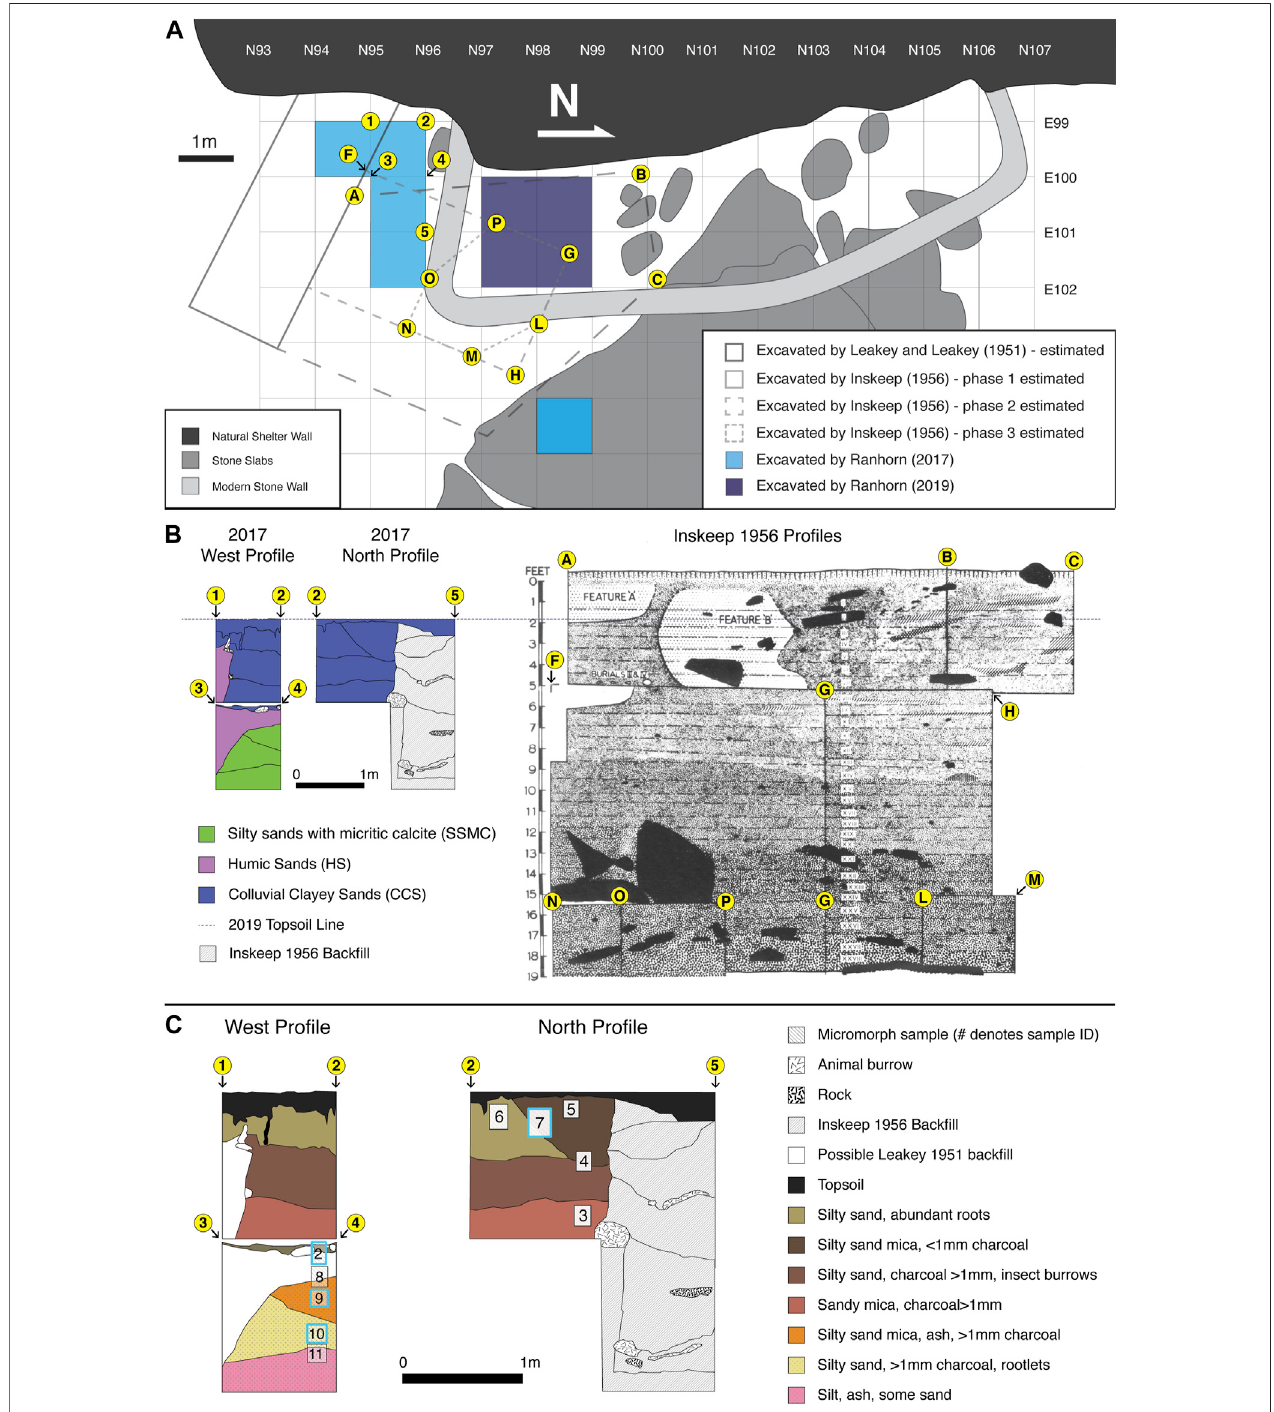
FIGURE 10 | Location and sedimentary context of the historic and modern excavations at Kisese II. The location of historic trenches was estimated using historic drawings, photographs, and the location of features as observed in modern excavations. Letters in circles (representing positions identi fi ed by Inskeep in original drawings) and numbers in circles (representing positions from the modern excavations) indicate the same locations as shown in plan and section view. (A) : plan view of thesite.Northhereindicatesgridnorth. (B) :Comparisonofthepro fi lesobservedinthe2017excavationcorrelatedwithInkeep ’ spro fi le.The2017pro fi leshowsthe three sediment packs described in the text. (C) : Detailed pro fi les from the 2017 excavations showing sediment characteristics, features, and the position of micromorphology samples described in the text. Samples shown in Figure 11 are outlined in blue.